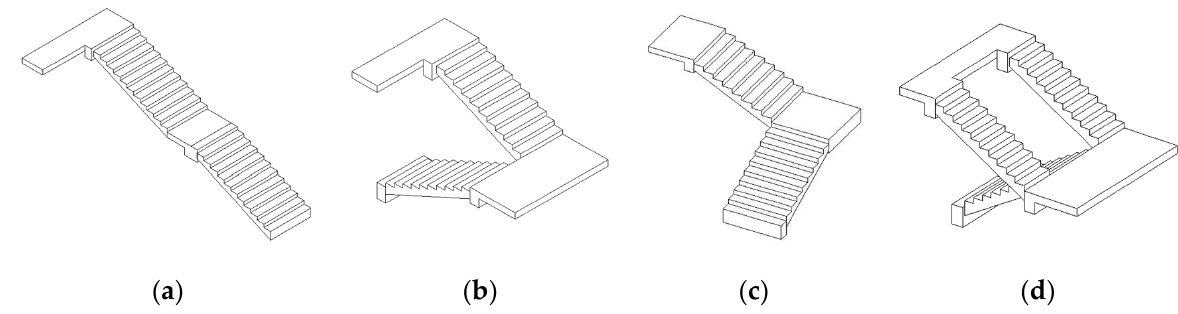
Figure 1. Four types of common staircases. ( a ) Straight running stairs with platform (SSP); ( b ) double running parallel stairs (DPS); ( c ) corner stairs (CS); ( d ) double split parallel stairs (DSS).